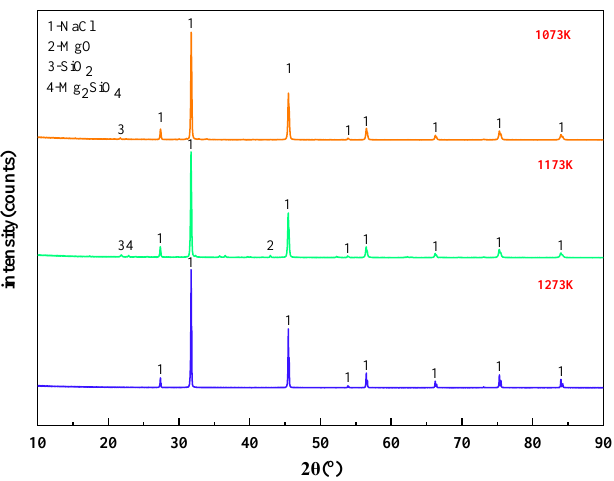
Figure 11. XRD of filtrate obtained with different temperatures.